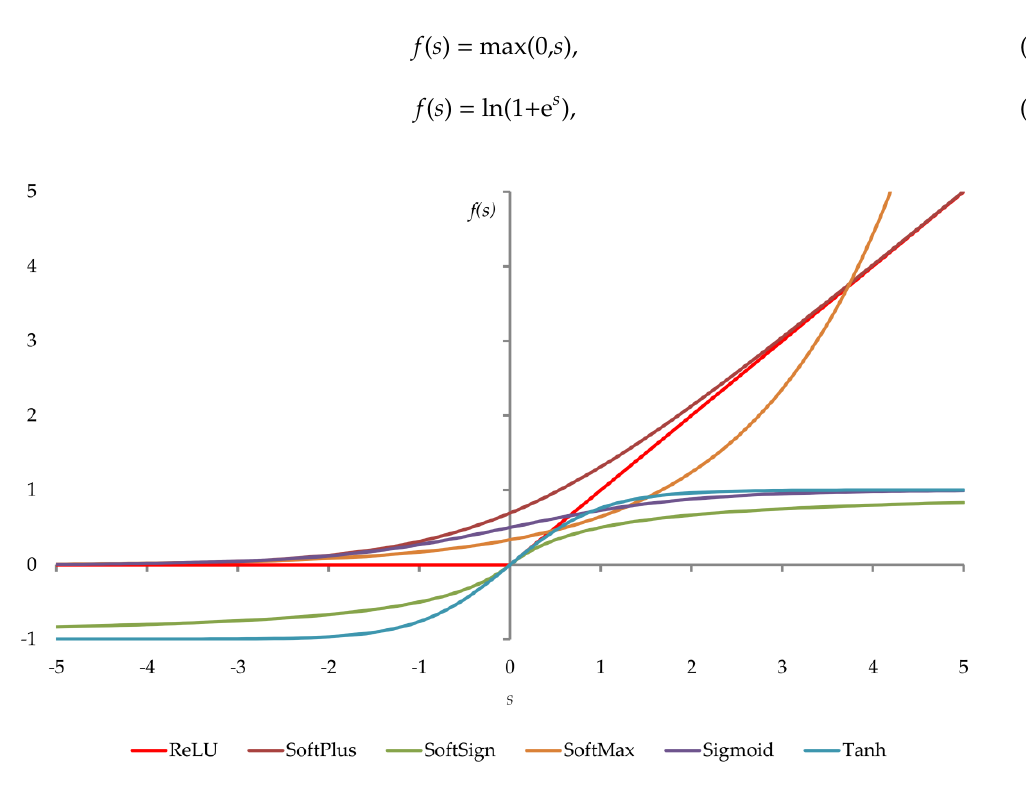
Figure 3. Graphs of six tested activation functions.